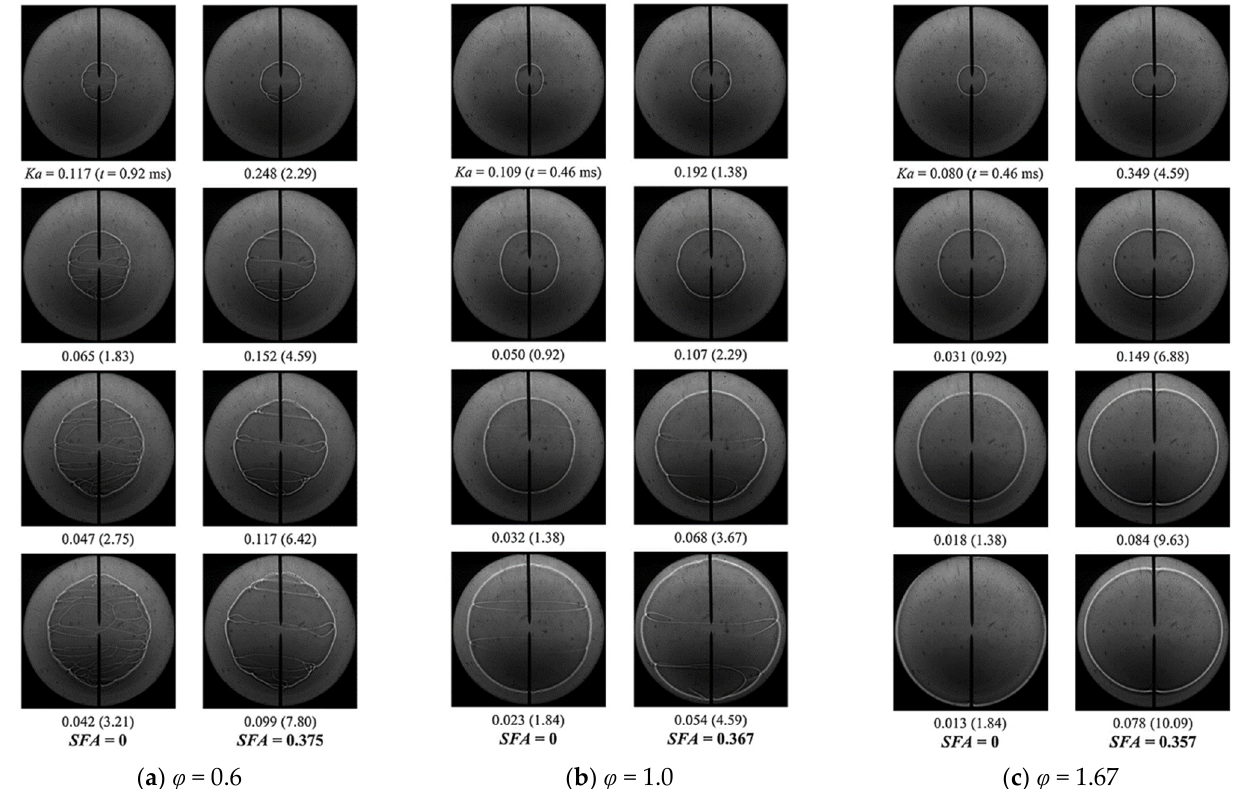
Figure 11. Shadowgraph photographs of NH 3 -substituted H 2 -air flames. SFA means the volumetric fraction of H 2 replaced by NH 3 : ( a ) φ = 0.6; ( b ) φ = 1.0; ( c ) φ = 1.67 at normal temperature and pressure. Courtesy of Elsevier [65].